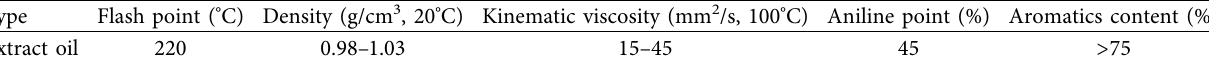
Table 3: Properties of the furfural extract oil.